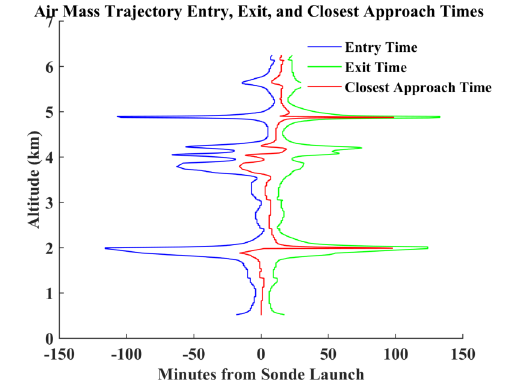
Figure 2: Air Mass trajectory entry (blue), exit (green), and closest approach (red) times. Entry and exit times correspond to the time when the air mass enters or exits the homogeneous region. The time of closest approach is the time at which the air mass is closest to the lidar. Integration times are determined by the exit and entry if the time spent inside the homogeneous region is less than 30 minutes. Otherwise, the integration time is 30 minutes around the time of closest